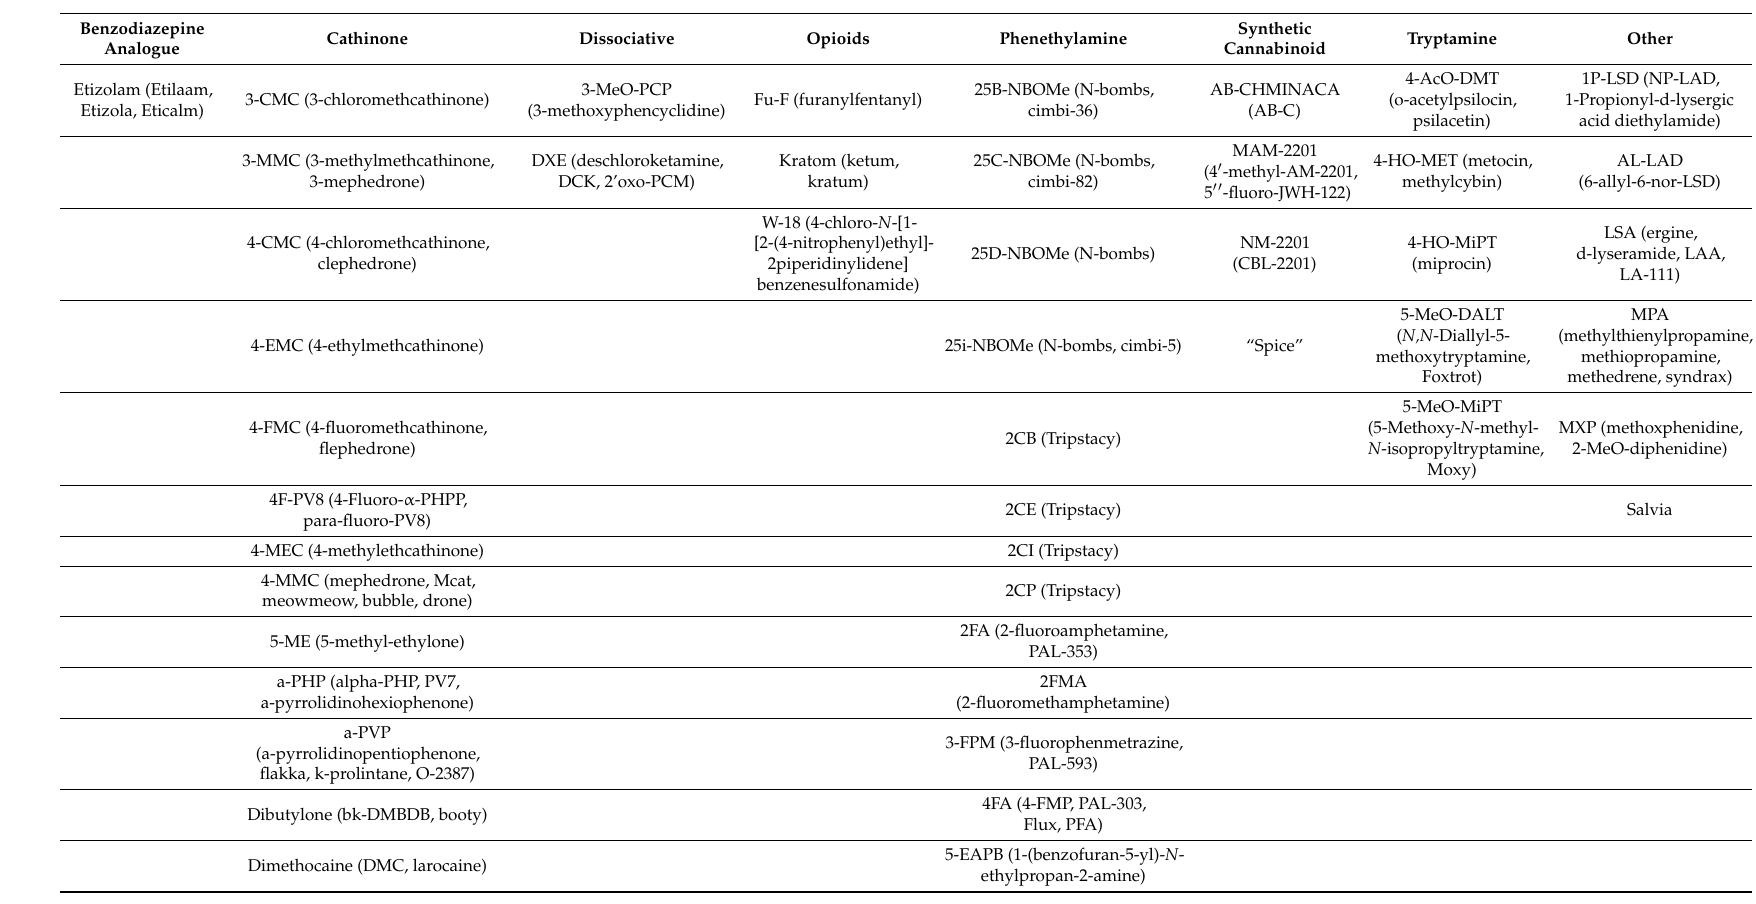
Table 1. New Psychoactive Substances that were available in every snapshot over 12 months of data collection ( n =